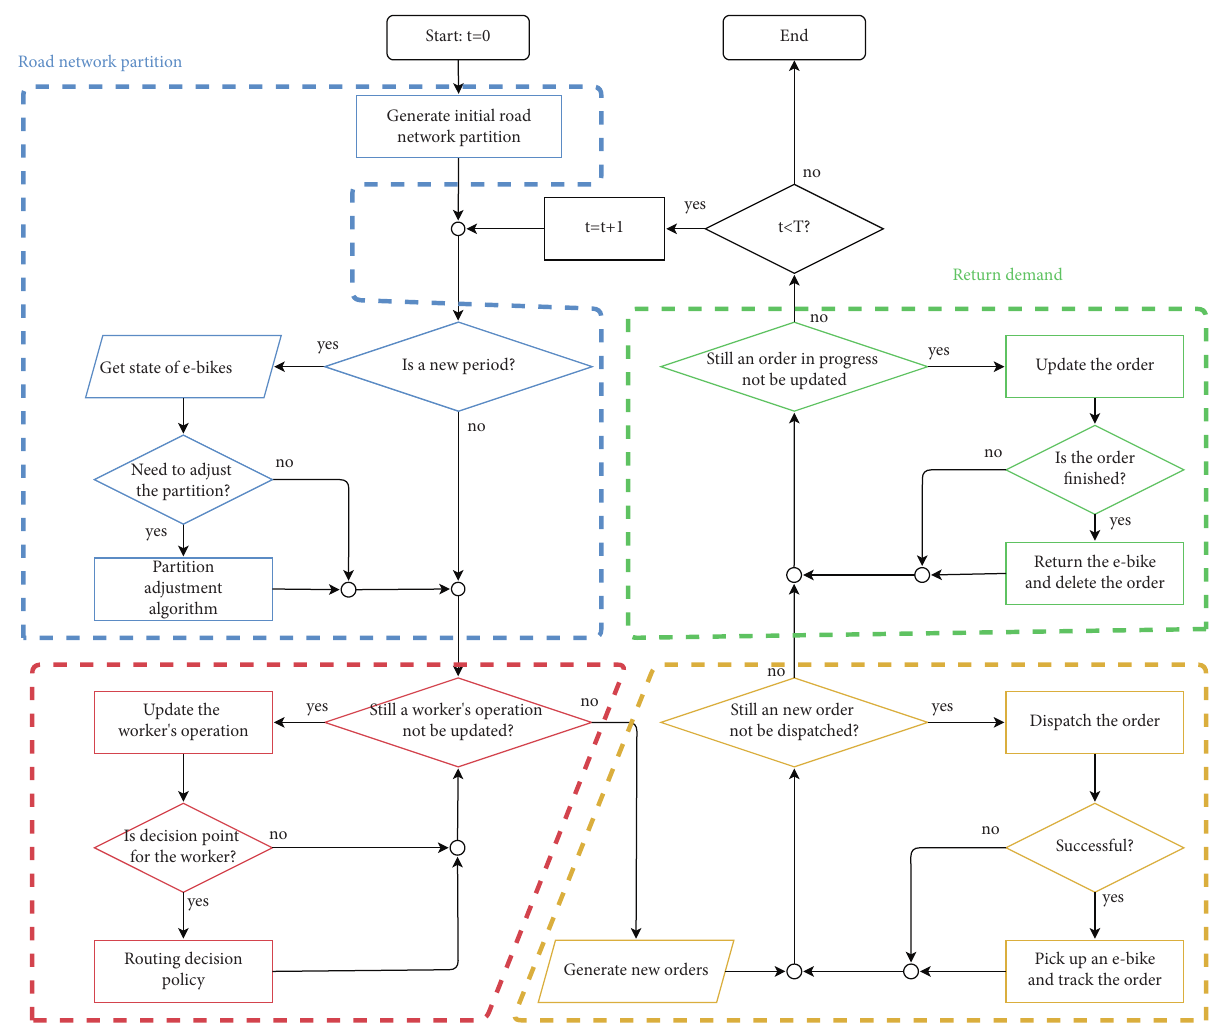
Figure 8: The simulation flowchart.